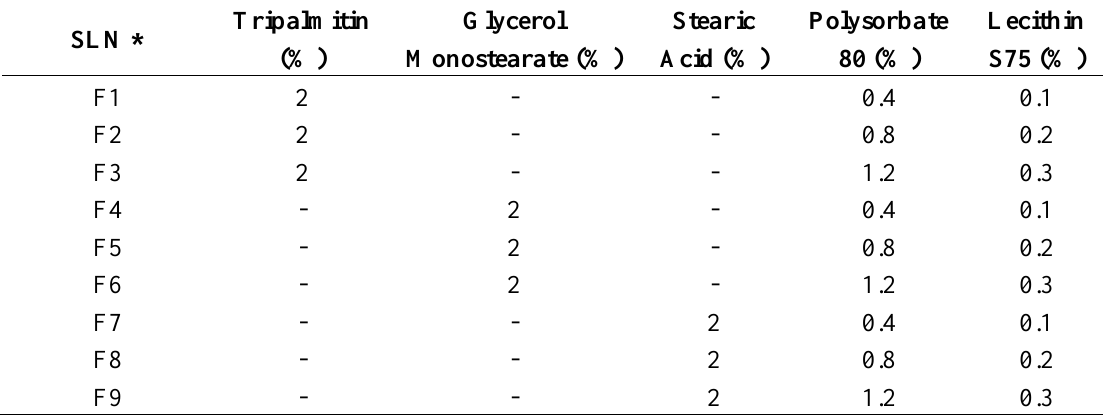
Table 1. Composition of SLNs.